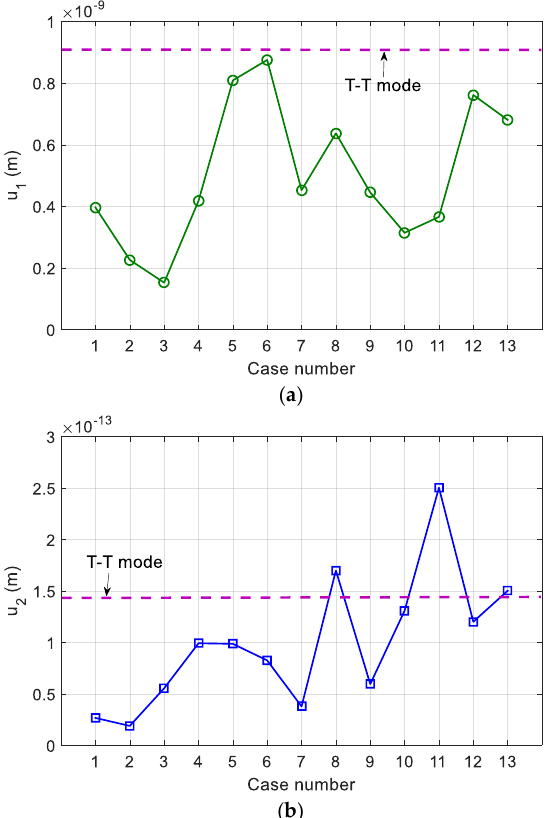
Figure 6. The received average displacement, calculated using the simulation parameters of Table 2: ( a ) Fundamental wave and ( b ) second harmonic wave. T-T mode denotes the through-transmission mode.